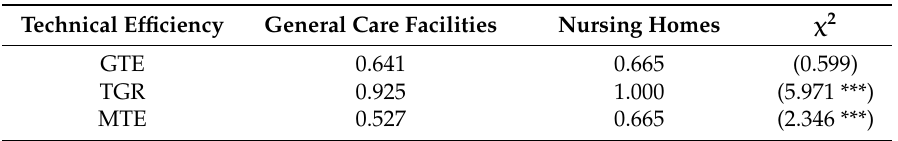
Table 10. Mann–Whitney χ 2 test of technical